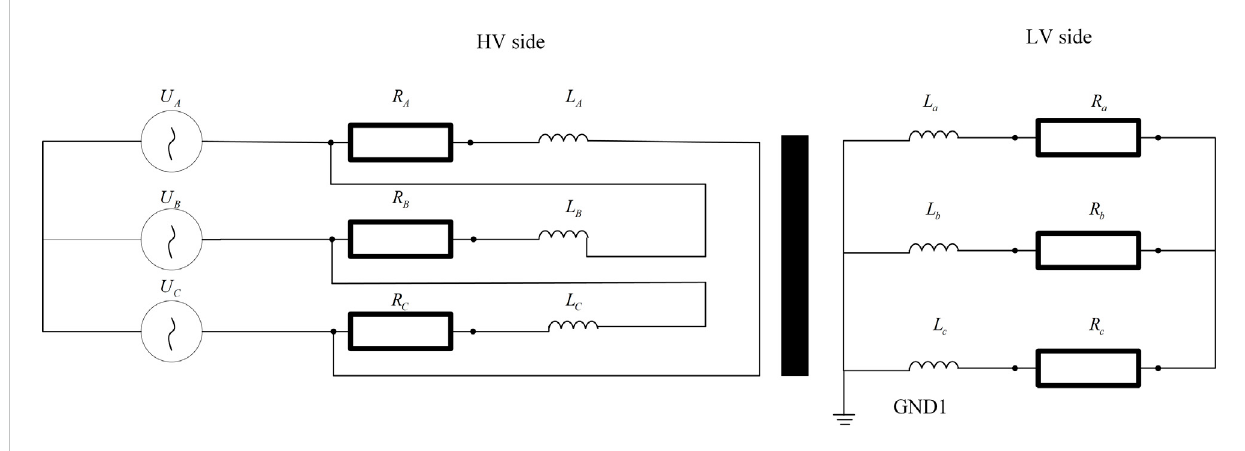
FIGURE 1 Power transformer circuit simulation